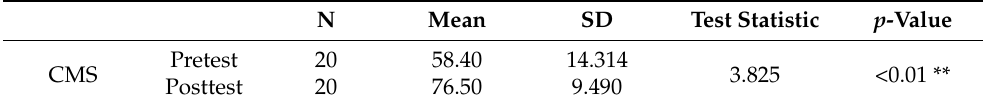
Table 2. Summary statistics and Wilcoxon rank sum test for comparing CMS between pretest and